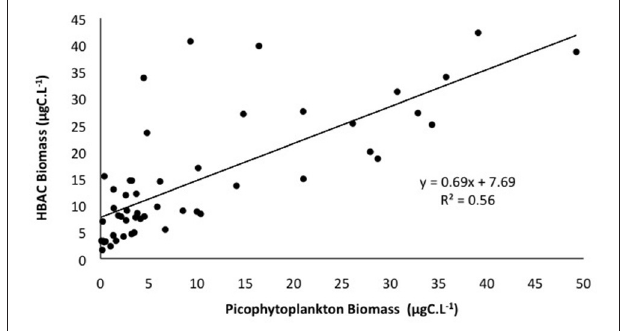
FIGURE 7 | Relationship between total carbon biomass ( µ gC.L − 1 ) of picophytoplankton ( Synechoccocus , Prochlorococcus, and picoeukaryotes) and heterotrophic bacteria (HBAC). Linear regression is statistically significant at p <